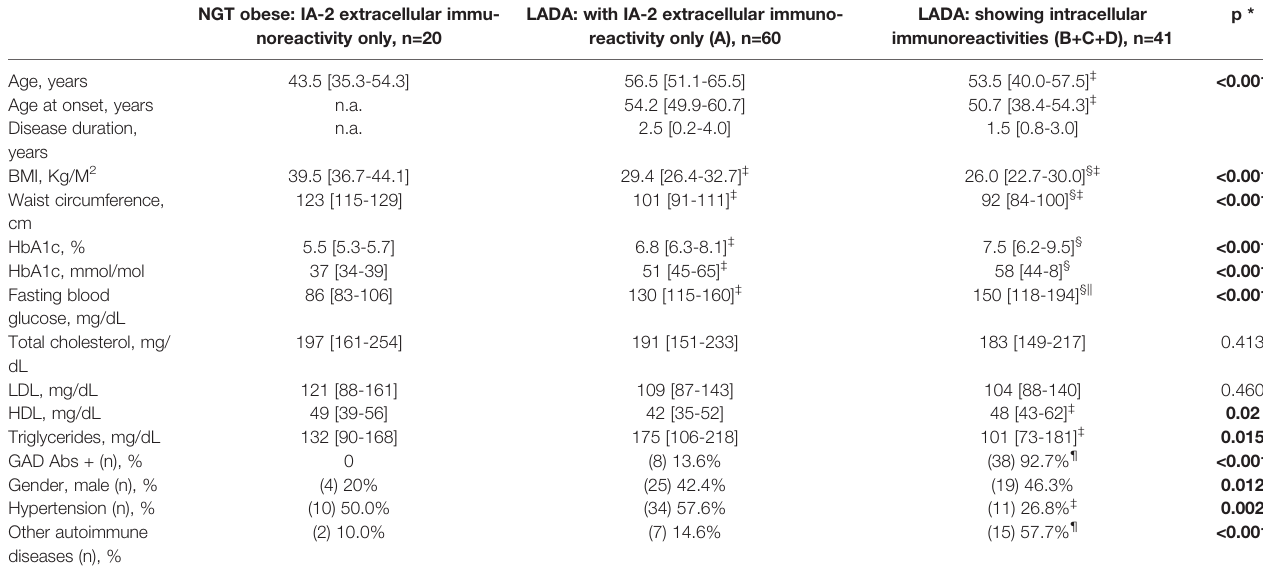
*P-value for the difference among the three groups. ‡ only LADA with only IA-2 extracellular immunoreactivity (A) Vs NGT obese p<0.001; § only LADA showing intracellular immunoreactivities (B+C+D) Vs NGT obese p<0.001; || only LADA with only IA-2 extracellular immunoreactivity (A) Vs LADA showing intracellular immunoreactivities (B+C+D) p=0.05; ‡ only LADA with only IA-2 extracellular immunoreactivity (A) Vs LADA showing intracellular immunoreactivities (B+C+D) p<0.01; ¶ only LADA with only IA-2 extracellular immunoreactivity (A) Vs LADA showing intracellular immunoreactivities (B+C+D) p<0.001. Signi fi cant p-values are provided in